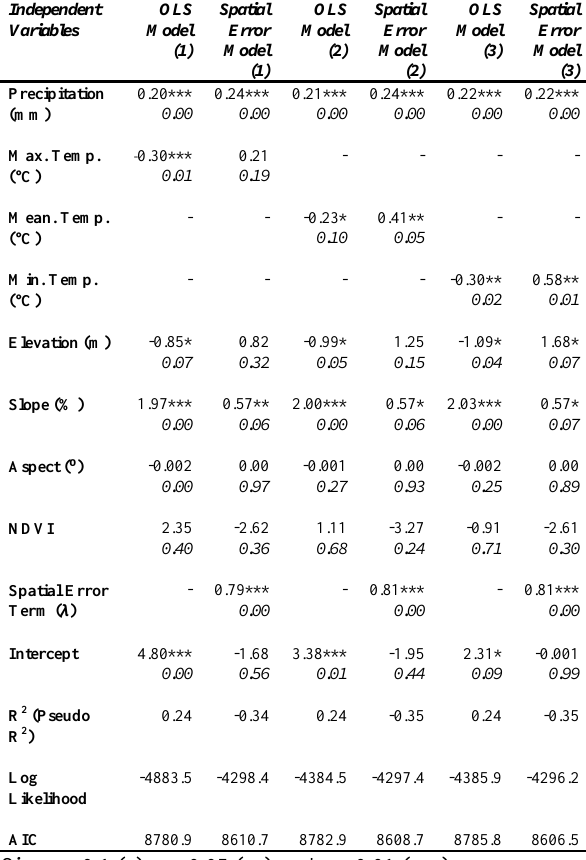
Table 4. OLS and spatial error regression models of relationships between SOC (dependent variable) and environmental factors (independent variables) (n=1317). Models (1), (2), and (3) include maximum, mean, and minimum temperature as one of the independent variables, respectively.